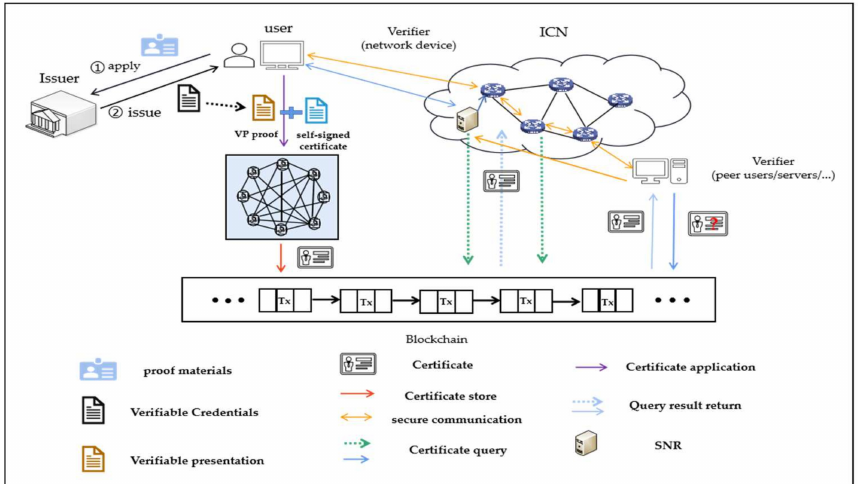
Figure 1. System